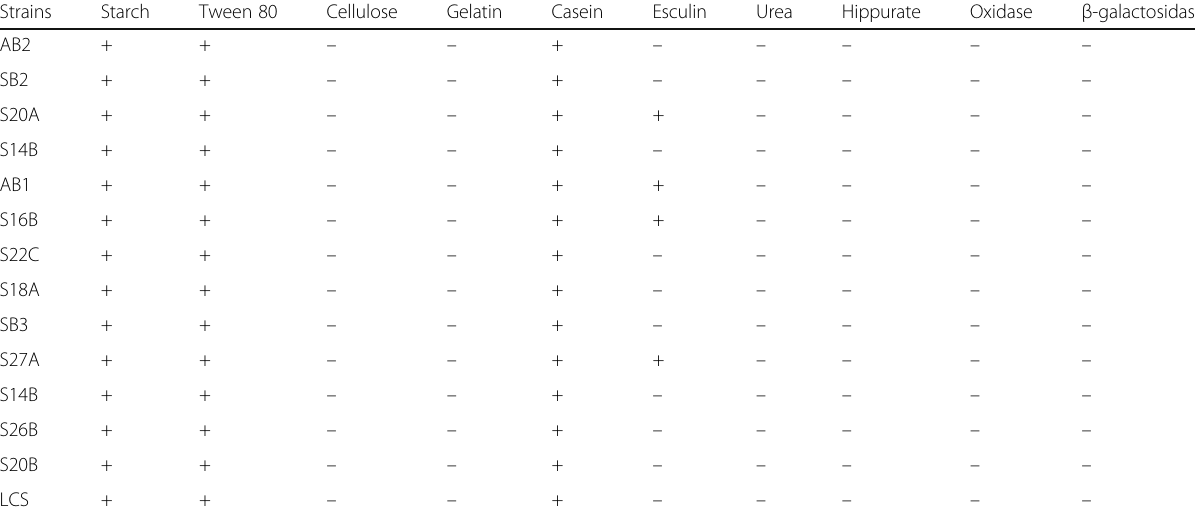
Table 1 Qualitative study of hydrolysis of various substrates by Enterococcus strains